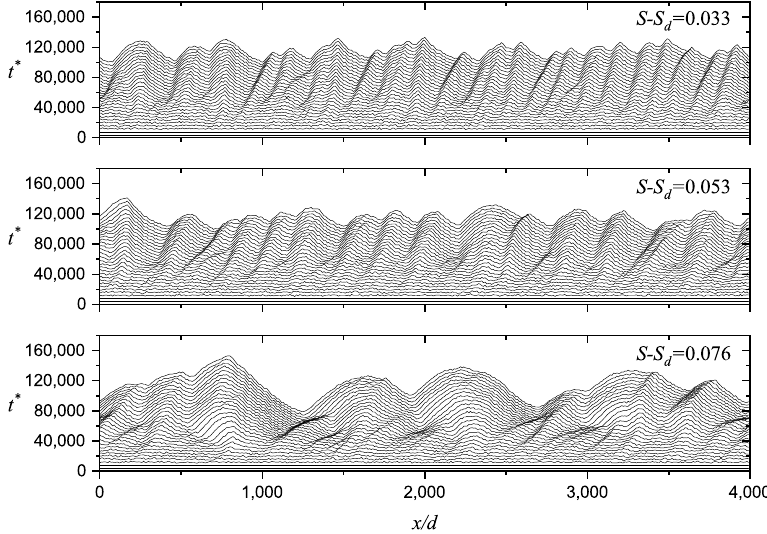
Figure 2. The spatial–temporal evolution of aeolian sand ripples in different wind strengths.